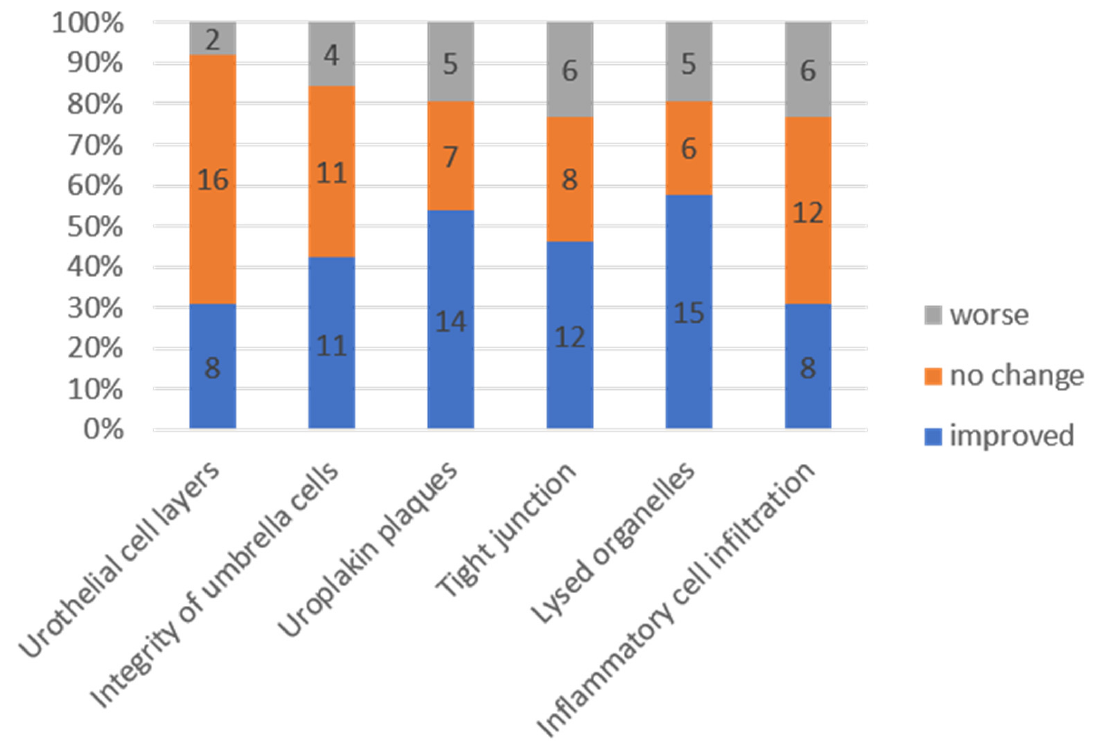
Figure 3. Changes in urothelial ultrastructural defects from baseline to after the platelet-rich plasma injections.